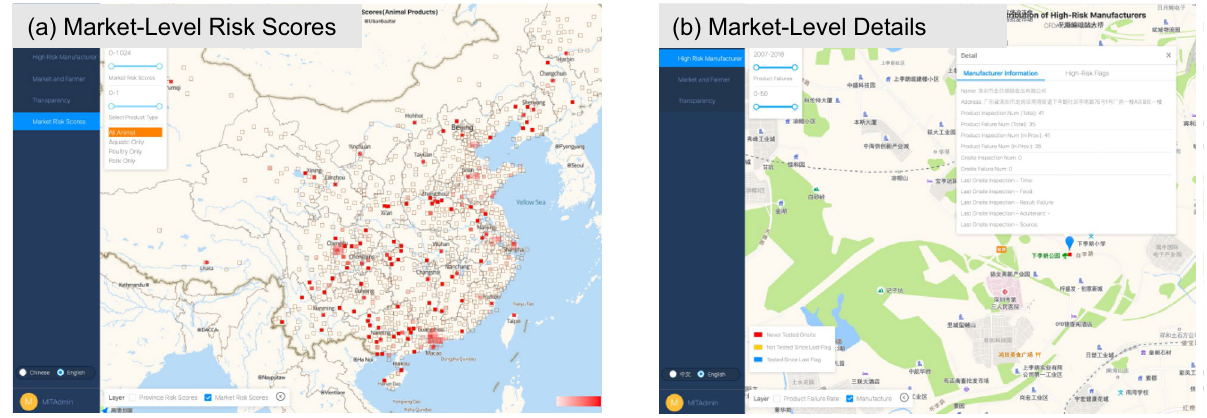
Figure 3. Market risk score tool. The market-level risk scores are shown in ( a ) with darker (lighter) red indicates a higher (lower) value of risk scores. When clicking on a market, the operational tool also communicates the name and address as well as the results of AMR food safety tests in that specific market as shown in ( b ), including what types of food were tested (e.g., poultry, pork), and what the results were for these food adulteration tests. The operational tool (https:// foods afety inchi na. azure websi tes. net/) was created in collaboration with iSoftStone using AntV G2 (https:// g2. antv. vision/ en).